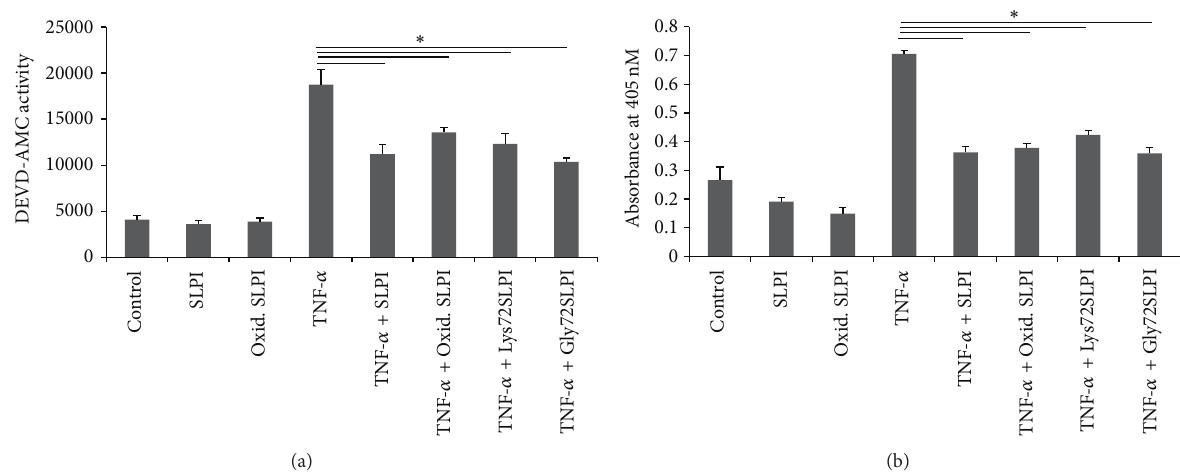
Figure 3: Effect of SLPI and oxidised SLPI on apoptosis in monocytic cells. U937 cells were pretreated with SLPI (10 𝜇 g/mL) or oxidised SLPI (10 𝜇 g/mL) and stimulated with TNF- 𝛼 (10ng/mL) for 4hr. (a) Activity of the effector caspases, caspase-3 and caspase-7, was measured using the fluorogenic substrate DEVD-AMC. (b) The amount of apoptosis occurring in cells was assessed by ELISA (Roche). Results are representative of 𝑛 = 3 . ∗ indicates 𝑝 < 0.05 .